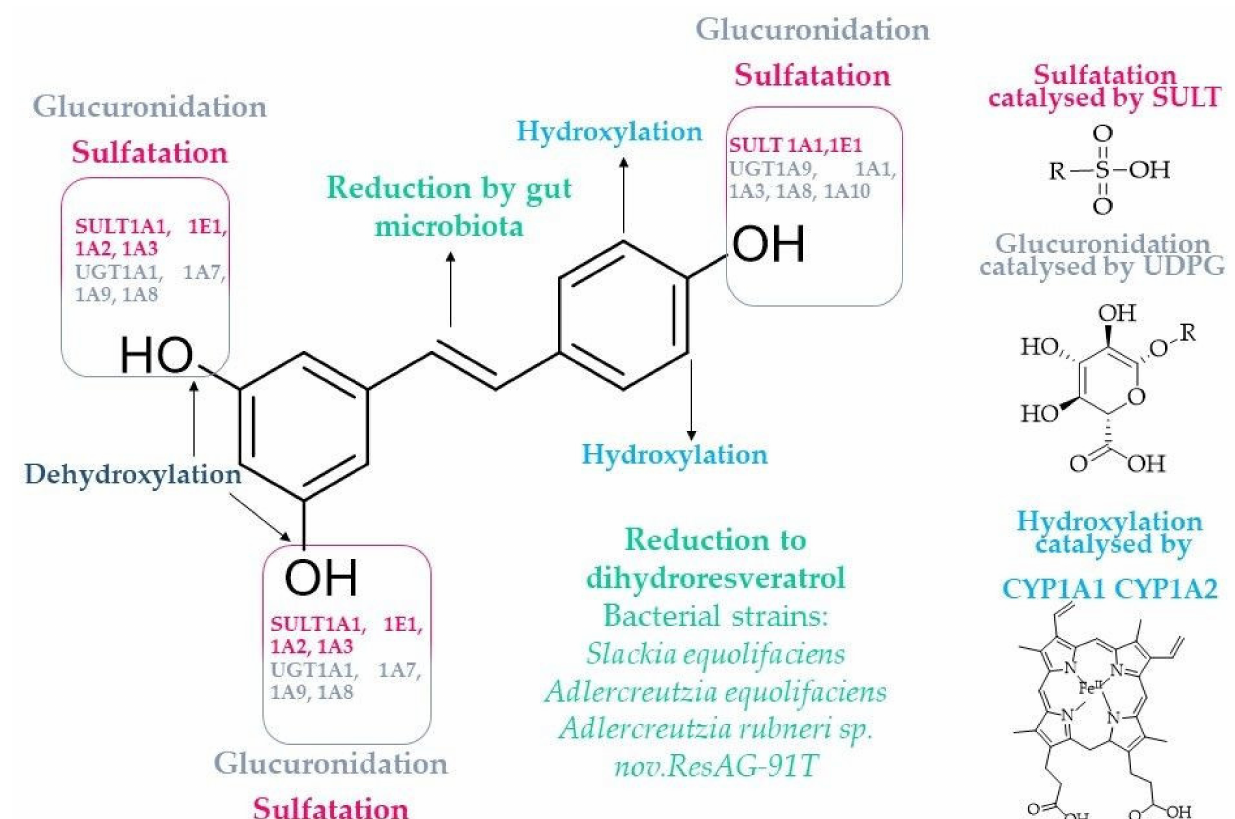
Figure 5. Main targets for drug-metabolizing enzymes in resveratrol molecule [28,60,65,66,68,69]. Resveratrol is eliminated from the body through urine and faeces, with a varied recov- ery between 54% and 98% [46]. In a Phase I clinical trial, urinary excretion of resveratrol and its metabolites were rapid, with 77% of all metabolites derived from the compound excreted within 4 h of the 500 mg dose